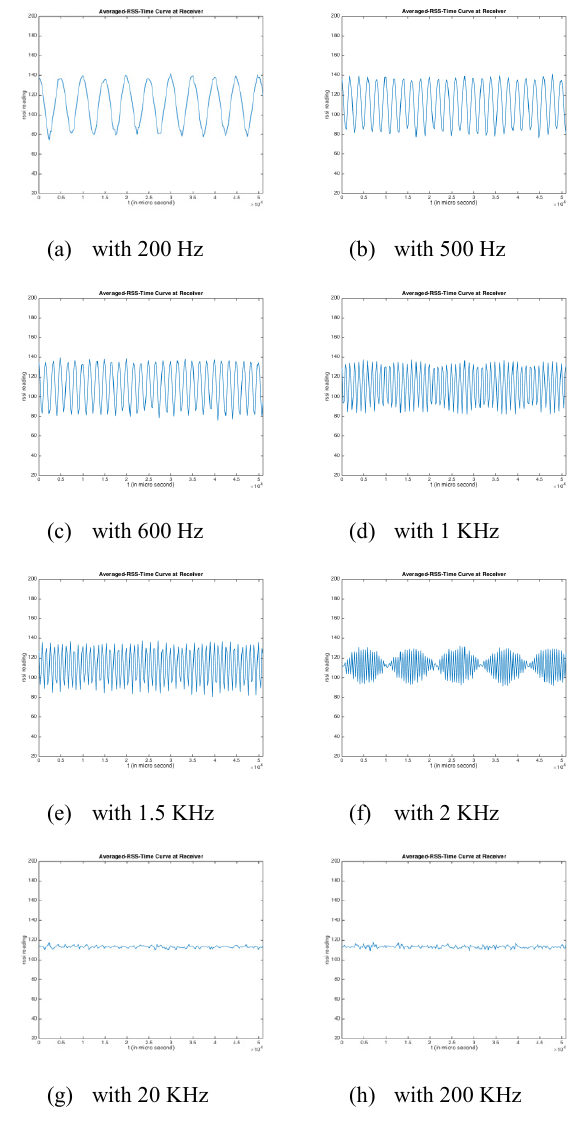
Fig. 6. Average-RSS-Time Curves with Different Carrier Frequency Differences